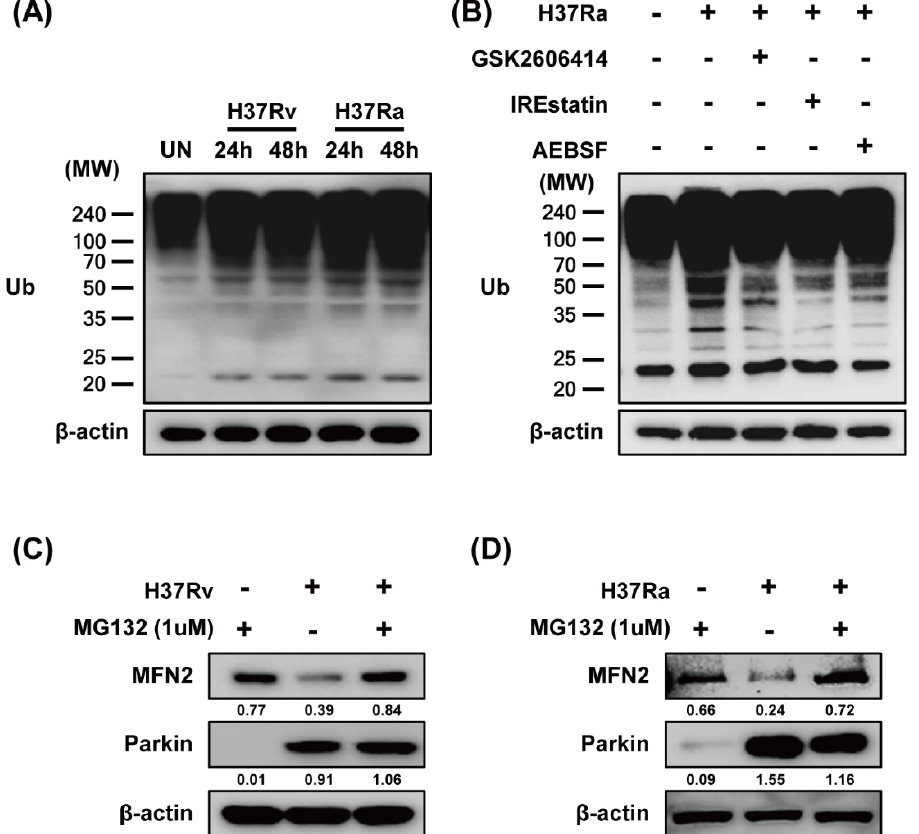
Figure 5. Mtb-induced Parkin regulates MFN2 production via the ubiquitin-proteasome system. ( A ) BMDMs were infected with Rv or Ra for 3 h. The cell lysates were subjected to western blotting for ubiquitin. ( B ) BMDMs in the presence or absence of ER stress inhibitors (10 μ M GSK2606414, 5 μ M IREstatin, 500 μ M AEBSF) or ( C and D ) MG132 for 1 h, before infection with Rv or Ra. At 48 h after Mtb infection, western blotting for ubiquitin, Parkin, and MFN2 was performed. β -actin was used as